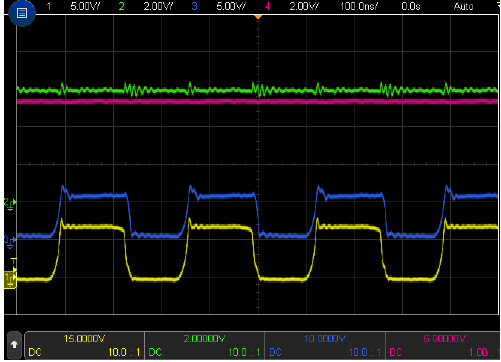
Figure 10. Waveforms of the isolator.